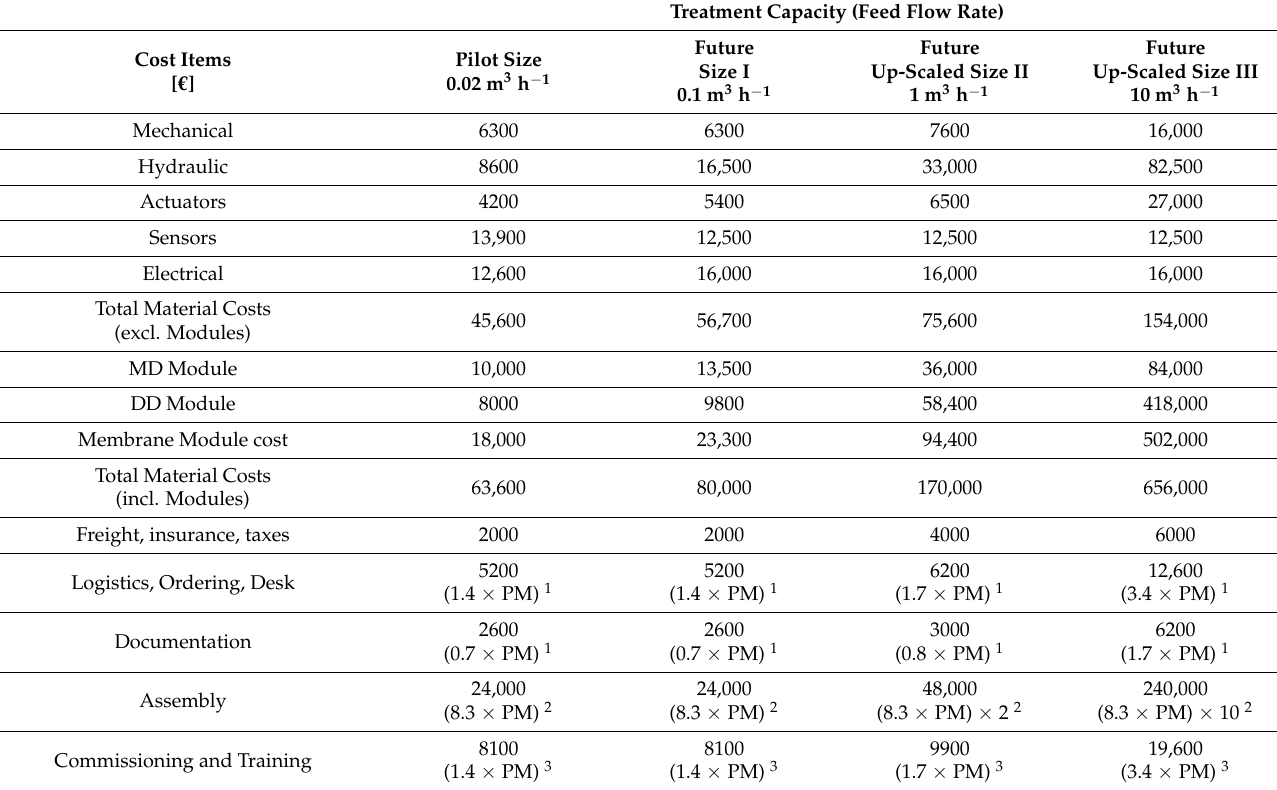
Table 2. FCI analysis at different treatment